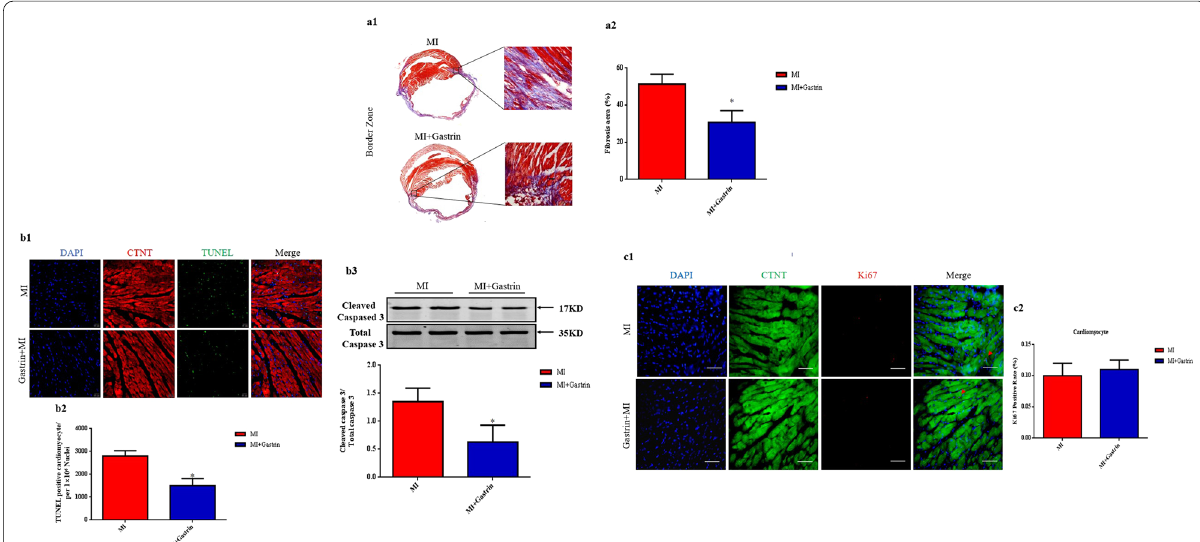
Fig. 3 Gastrin decreases cardiomyocyte apoptosis and fibrosis after myocardial infarction. a Representative images ( a1 ) and quantification ( a2 ) of the fibrotic area in infarct border zone by Masson trichrome staining at 28 days post-MI. b Representative images ( b1 ) and quantification ( b2 ) of terminal deoxynucleotidyl transferase dUTP nick-end labeling–positive (TUNEL + ) cardiomyocytes in infarct border zone at 2 days after MI. TUNEL + nuclei are stained green, cardiac troponin T antibody (cTnT) is red, and 4’-6-diamidino-2-phenylindole (DAPI) is blue. b3 Western blot was used to measure the protein levels of Caspase 3 in the infarct border zone at 2 days after MI. Results are expressed as the ratio of cleaved caspased 3 to total caspase 3. c , Representative images ( c1 ) and quantification ( c2 ) of cardiomyocyte proliferation 28 days after myocardial infarction, through Ki67 immunostaining. Cardiac troponin T antibody (cTnT) is green, Ki67 is red, and 4’-6-diamidino-2-phenylindole (DAPI) is blue. a and c Scale bar 50 µm. b Scale bar 20 µm. n 8. * P < 0.05, vs. MI mice. P NS means no significant = = = =